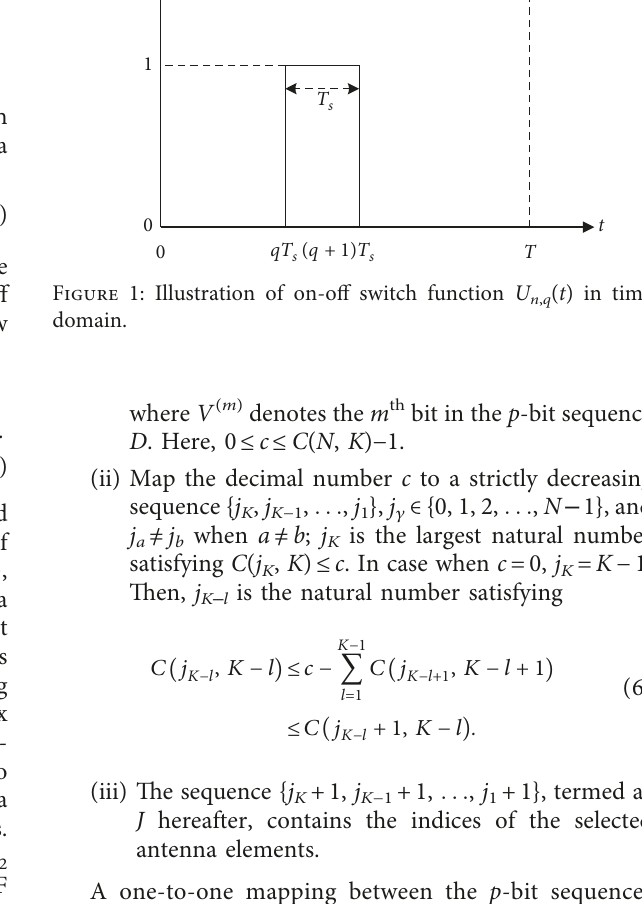
Figure 1: Illustration of on-off switch function U